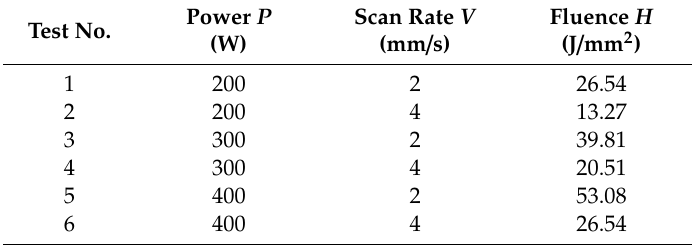
Table 5. Laser treatment parameters for the mullite nano–silica–NiCr (MSN) coatings. Test